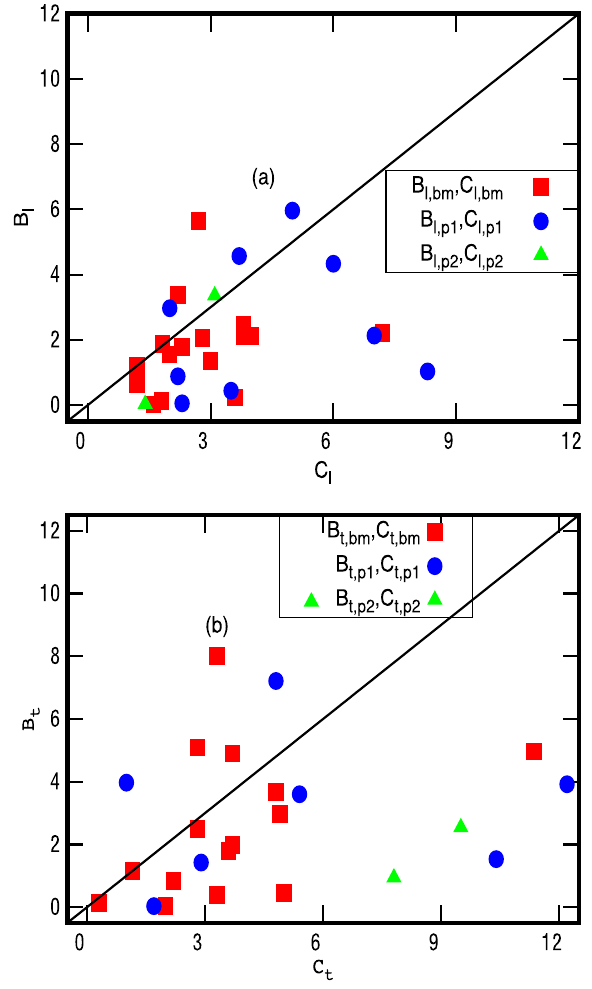
Figure 5. Comparison of B a -values ( a = l , t ), for 18 glasses from Eq. (47), for M = M 2 , with their experimentally known tunneling strengths : here the B a 1, xx -values correspond to y -coordinates of the points marked on the figure and C a , xx to their x -coordinates; the details of the labels are same as in Fig. 2. Here again the solid line is shown only for visual